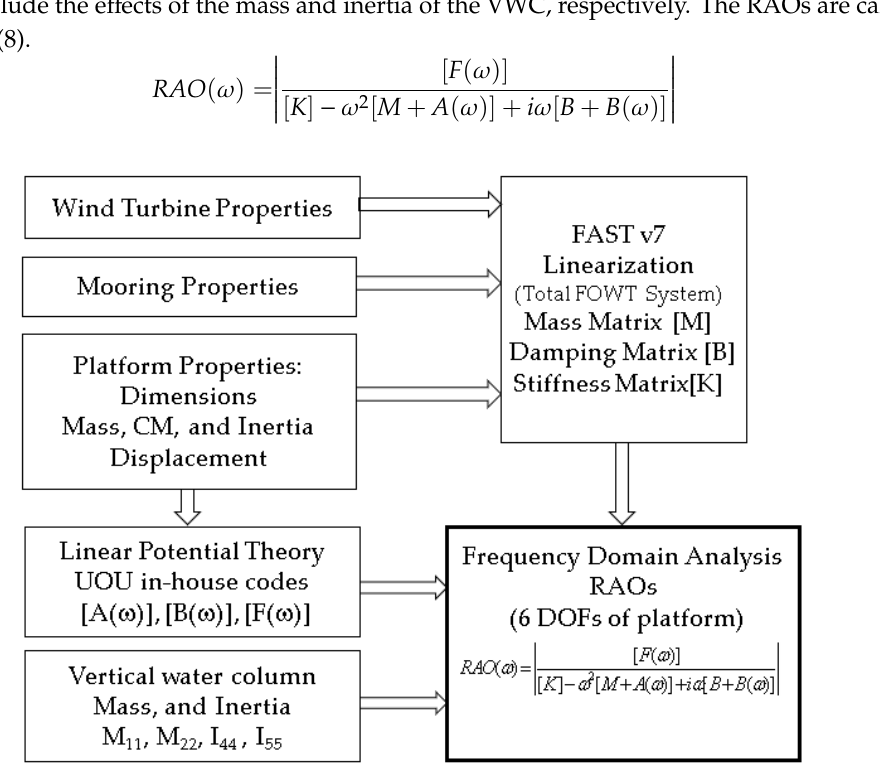
Figure 5. Frequency domain analysis. Note: DOF = degrees of freedom, CM = center of mass, UOU = University of Ulsan.